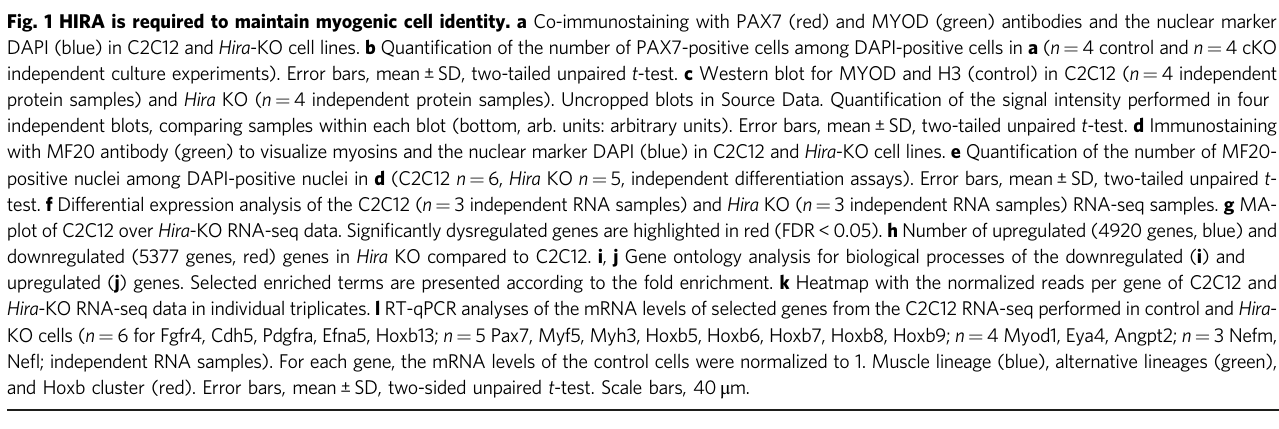
muscle to maintain the satellite cell pool. Consistently, the number of M-Cadherin-positive associated nuclei at 7 dpi, nor- malized to the unit area, was signi fi cantly decreased when Hira is deleted in satellite cells (Supplementary Fig. 3e). Consistent with the in vitro myogenic cell analysis, proliferation and cell death rates were not signi fi cantly affected in Pax7 CreErt2 ;Hira fl / fl satellite cells (Supplementary Fig. 3f – h). Loss of satellite cells in Pax7 CreErt2 ;Hira fl / fl injured muscles was associated with severely impaired regeneration capacity as shown by the high number of newly formed fi bers 7 dpi labeled with embryonic myosin heavy chain (MYH3) antibody (Fig. 3h, i) and the failure to generate fi bers of large cross-sectional area 28 dpi (Fig. 3j, k). These data demonstrate that muscle satellite cells lacking Hira fail to pre- serve the muscle stem cell pool and to ef fi ciently regenerate damaged skeletal